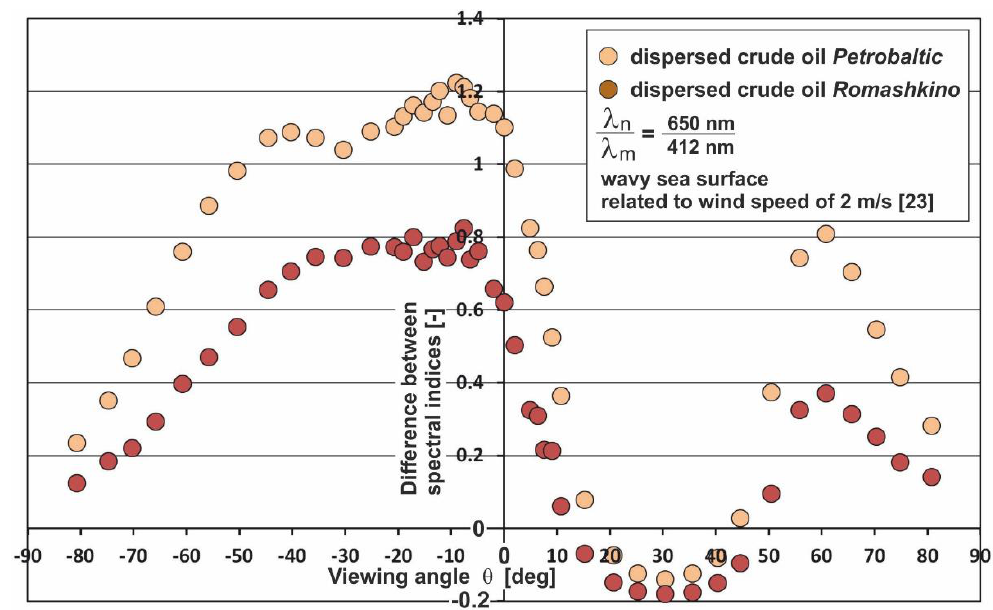
Figure 4. Viewing angle dependence of differences between spectral indices of seawater contaminated by dispersed oil and indices of seawater free of oil contamination, for chosen wavelengths λ n and λ m (650 nm and 412 nm).